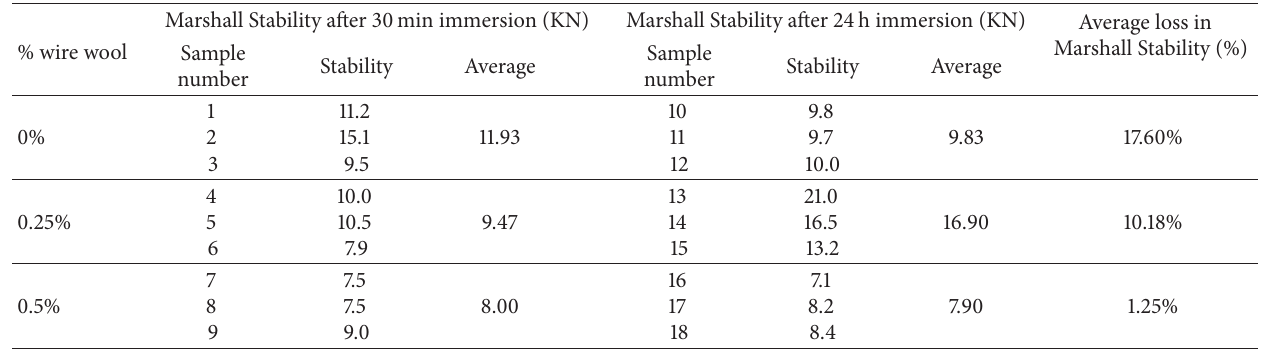
Table 3: Effect of wire wool addition on Marshall Stability.